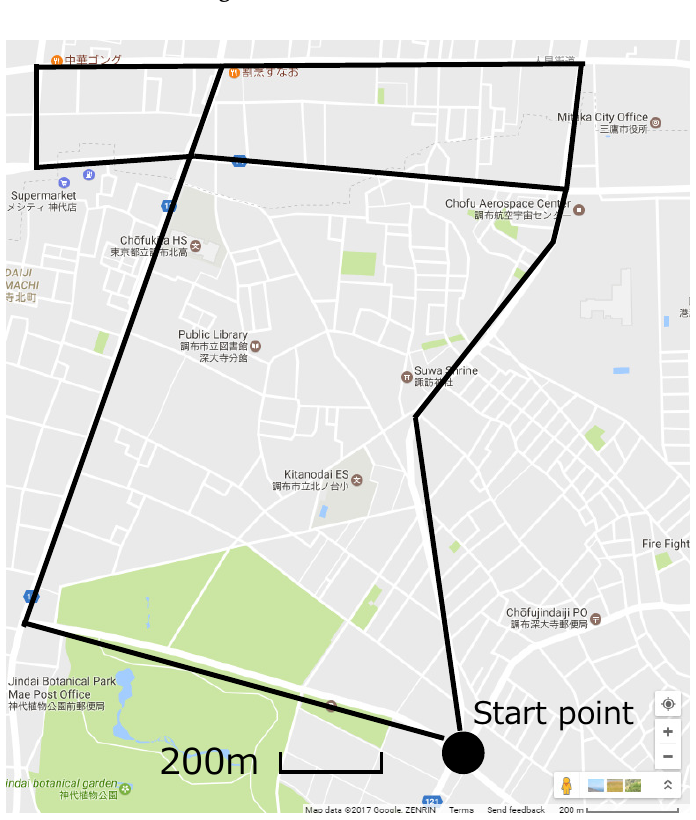
Figure 4. Measurement